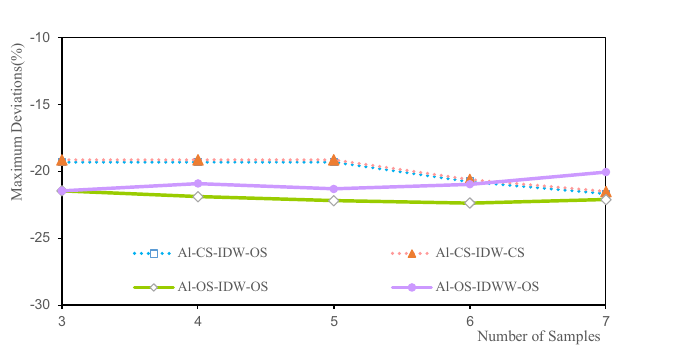
Figure 14. Deviation of the Al maximum grade.